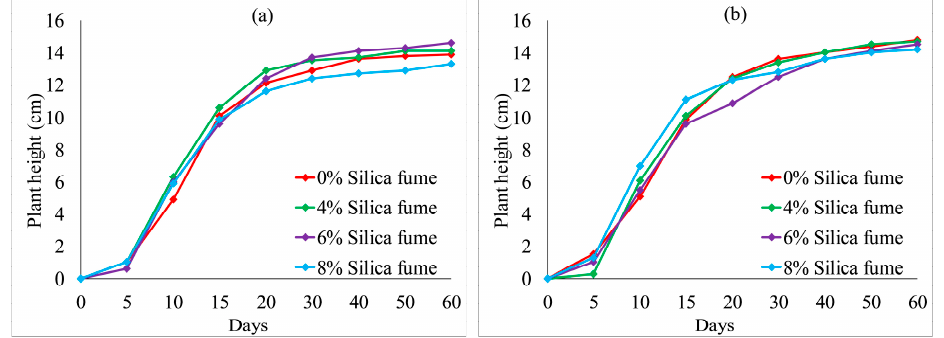
Figure 10. Ryegrass height related to silica fume combined with: ( a ) 5% KW fertilizer content; ( b ) 10% KW fertilizer content.